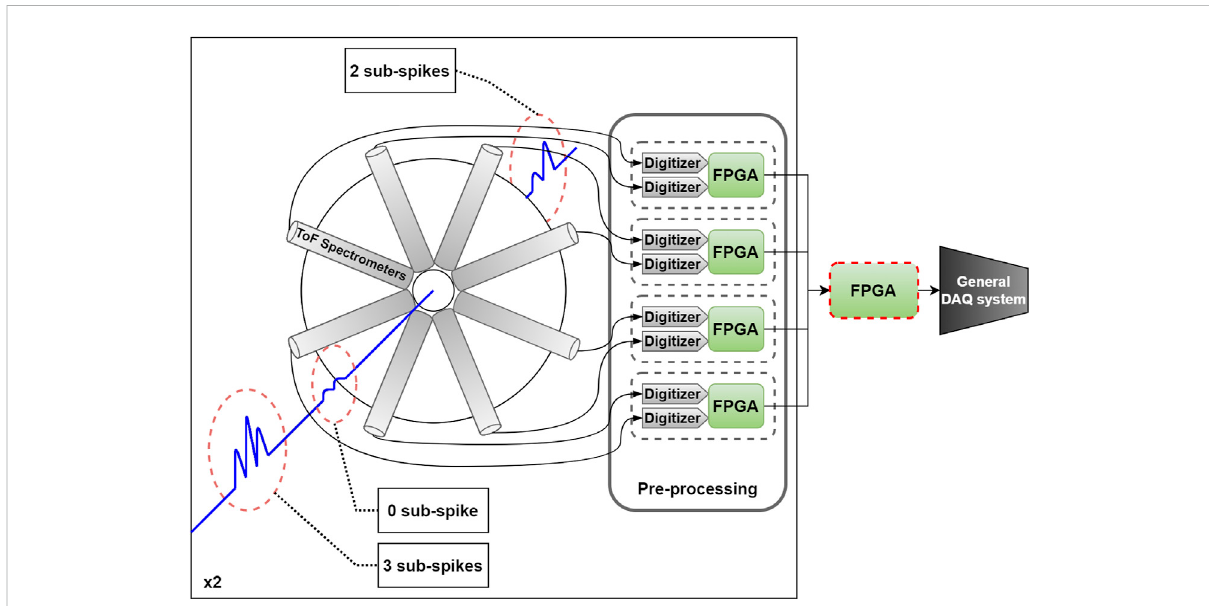
FIGURE 1 Diagram of the data fl ow of the CookieBox. The ToF spectrometers signals are processed by analog electronics before being digitized. Each 2digitizersfeedintoanFPGAthatwillbehostingtheneuralnetworkdiscussedinthisarticle.ThecentralFPGA,circledwithareddottedline,collects the extracted features from all 8 peripheral FPGA and forwards the inference results to the rest of the DAQ